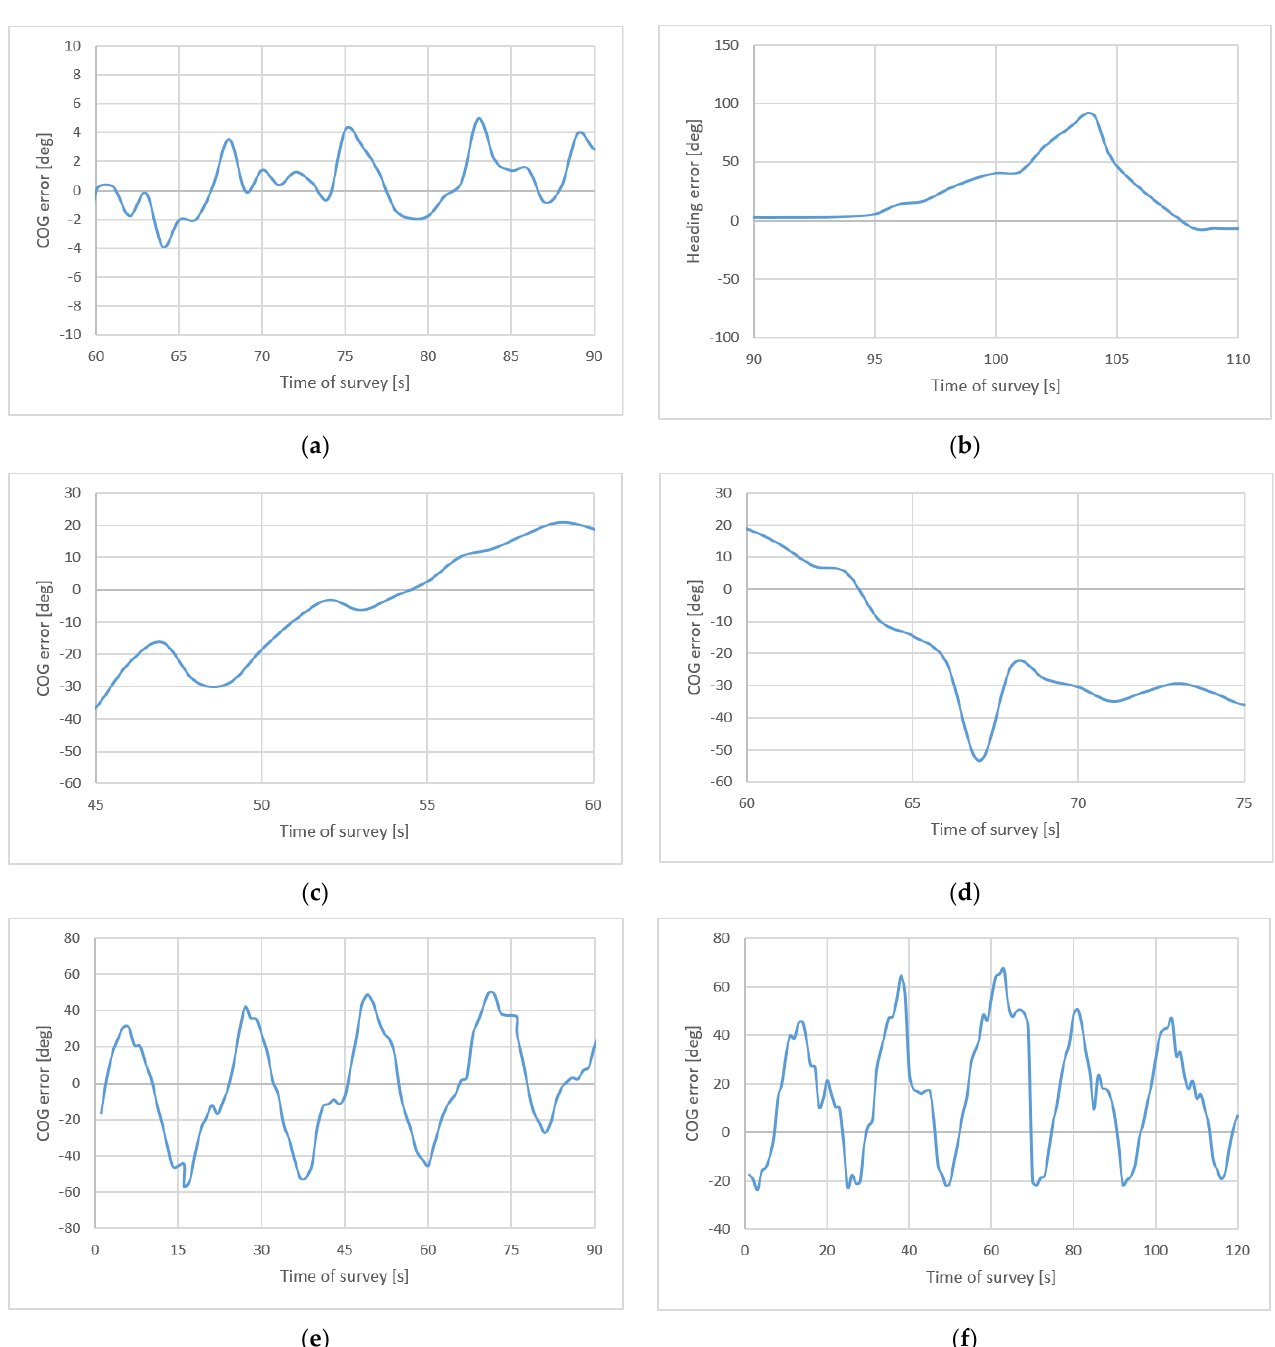
Figure 16. Differences between satellite compass heading and COG during surveys: long profile ( a ) and turning ( b ), short profile ( c ), quick heading changes ( d ), and circulations: right ( e ) and left ( f ).